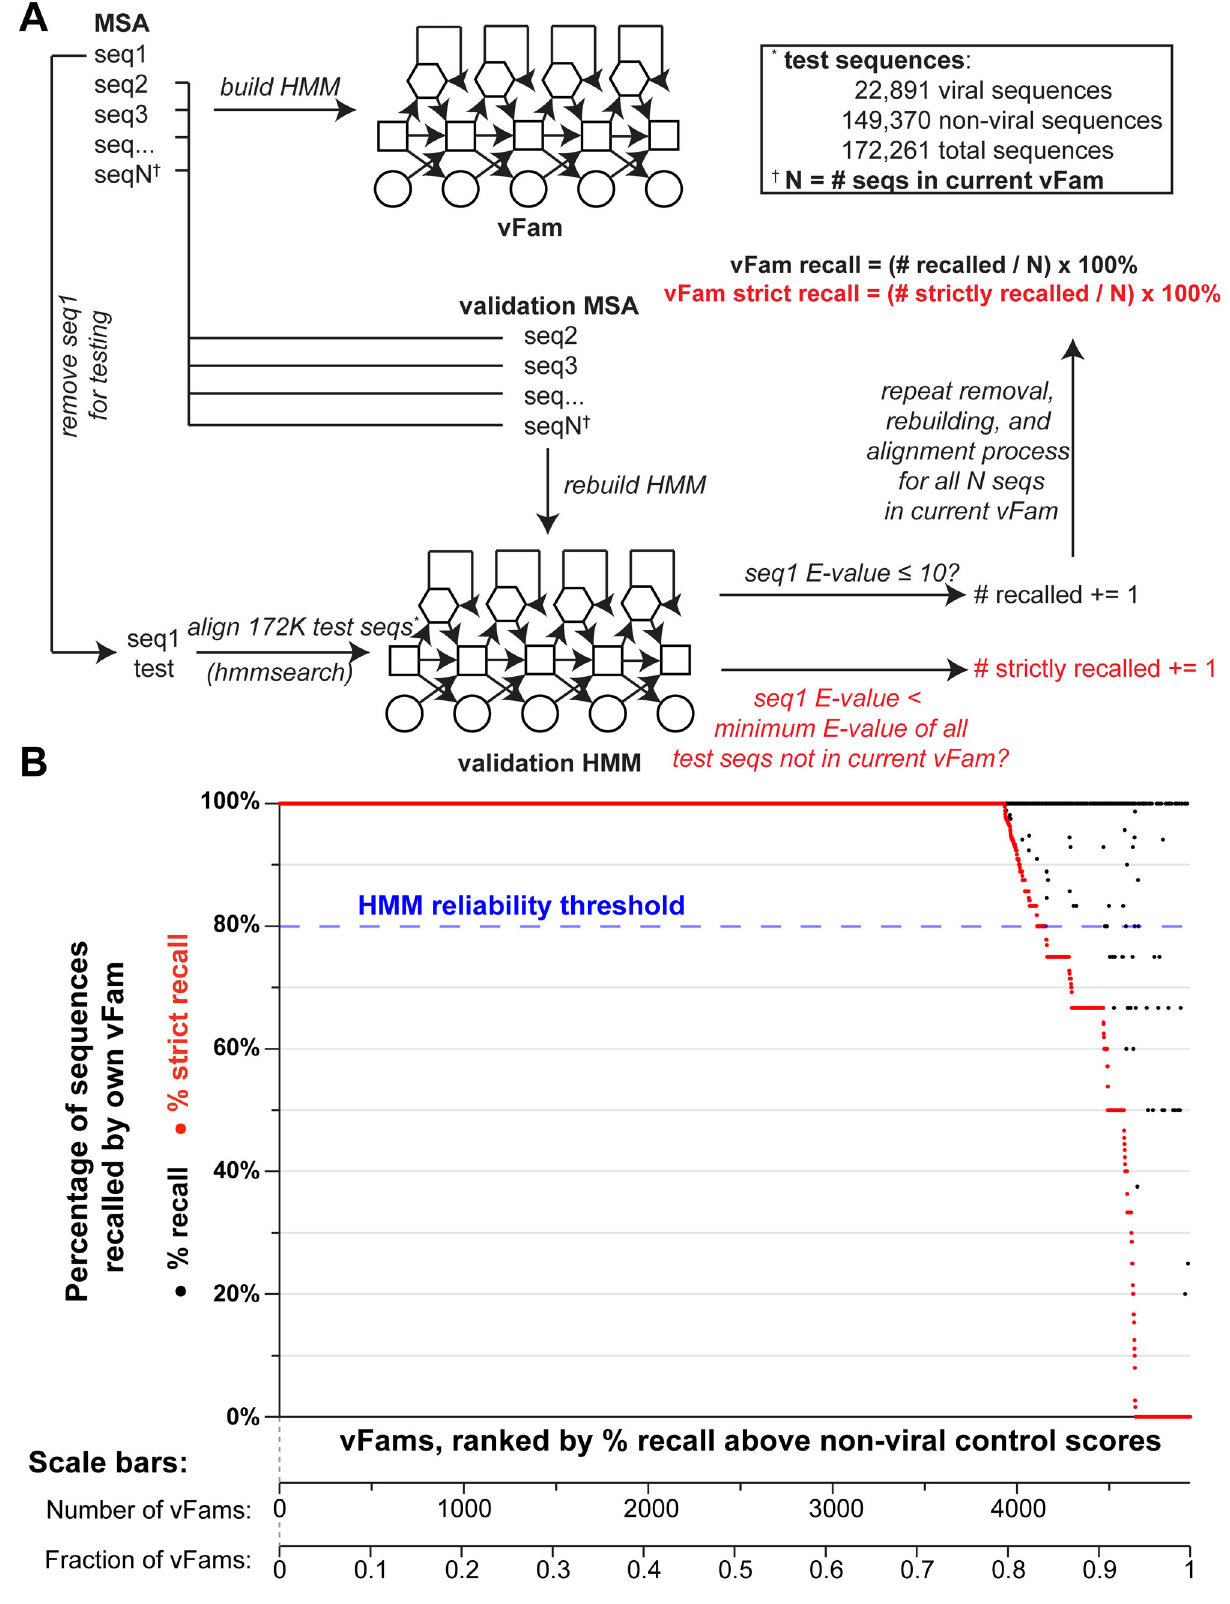
Figure 2. Viral sequence recall for all vFams in cross-validation. (A) A schematic representation of the cross-validation of the vFams is depicted for a single vFam. The initial multiple sequence alignment (MSA) and HMM building are depicted for the vFam being tested (top left). Each sequence is removed from the vFam exactly once, and a validation MSA and validation HMM are built from the remaining sequences. A set of test